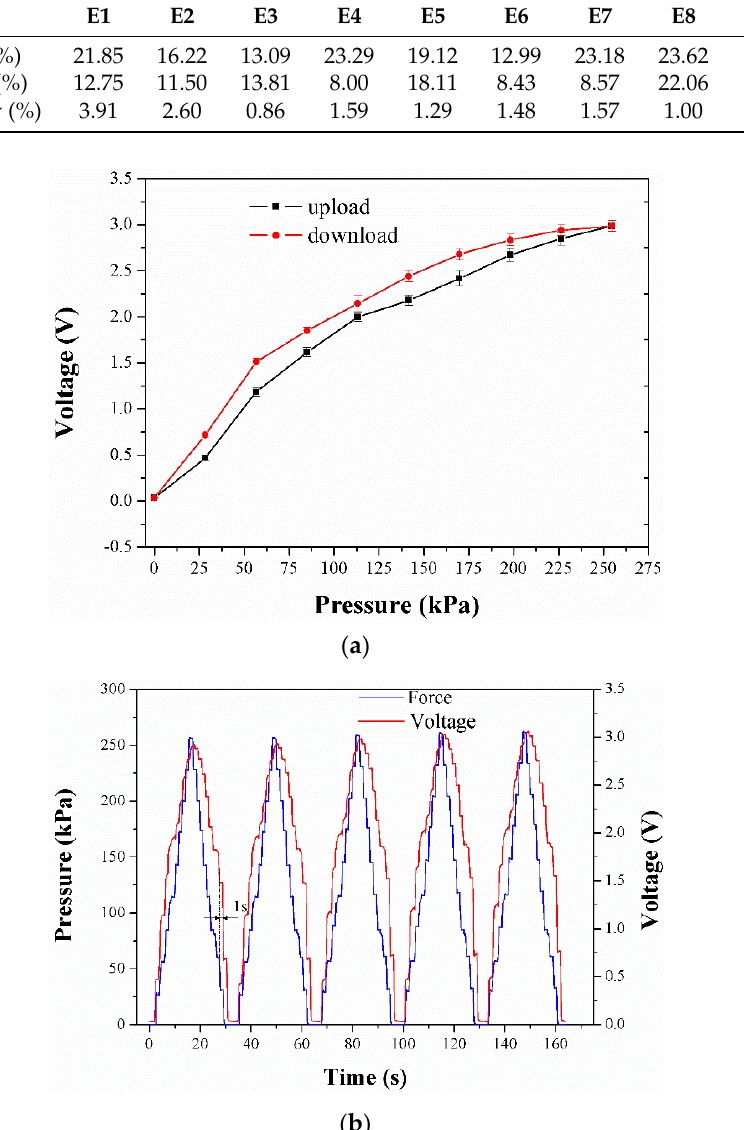
Figure 9. ( a ) Characteristic curve of sensing element 2; ( b ) output of sensing element 2 in five-cyclic